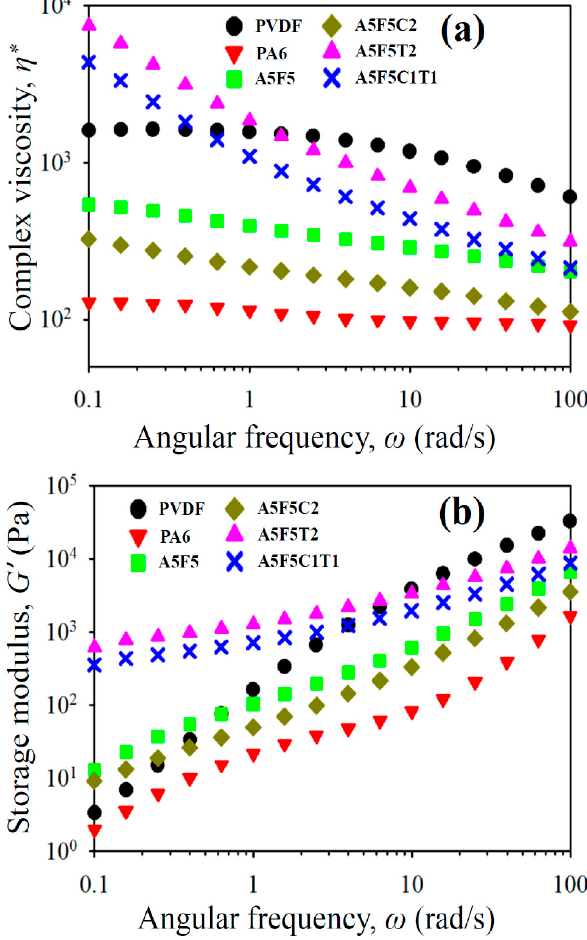
Figure 7. Rheological properties of the samples: ( a ) η * vs. ω and ( b ) G' vs. ω .